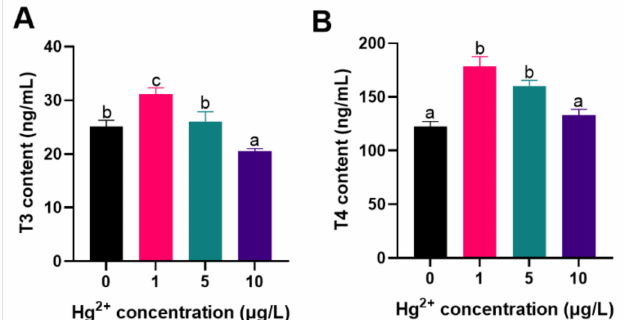
Figure 3. Response to the thyroid hormones levels of silver carp larvae exposed to Hg 2+ . ( A ) T3 content; ( B ) T4 content. Vertical bars represent the mean ± SE ( n = 3). Different letters indicate significant differences between groups ( p <